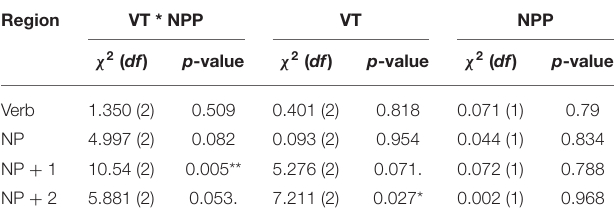
TABLE 4 | Results of likelihood ratio tests.